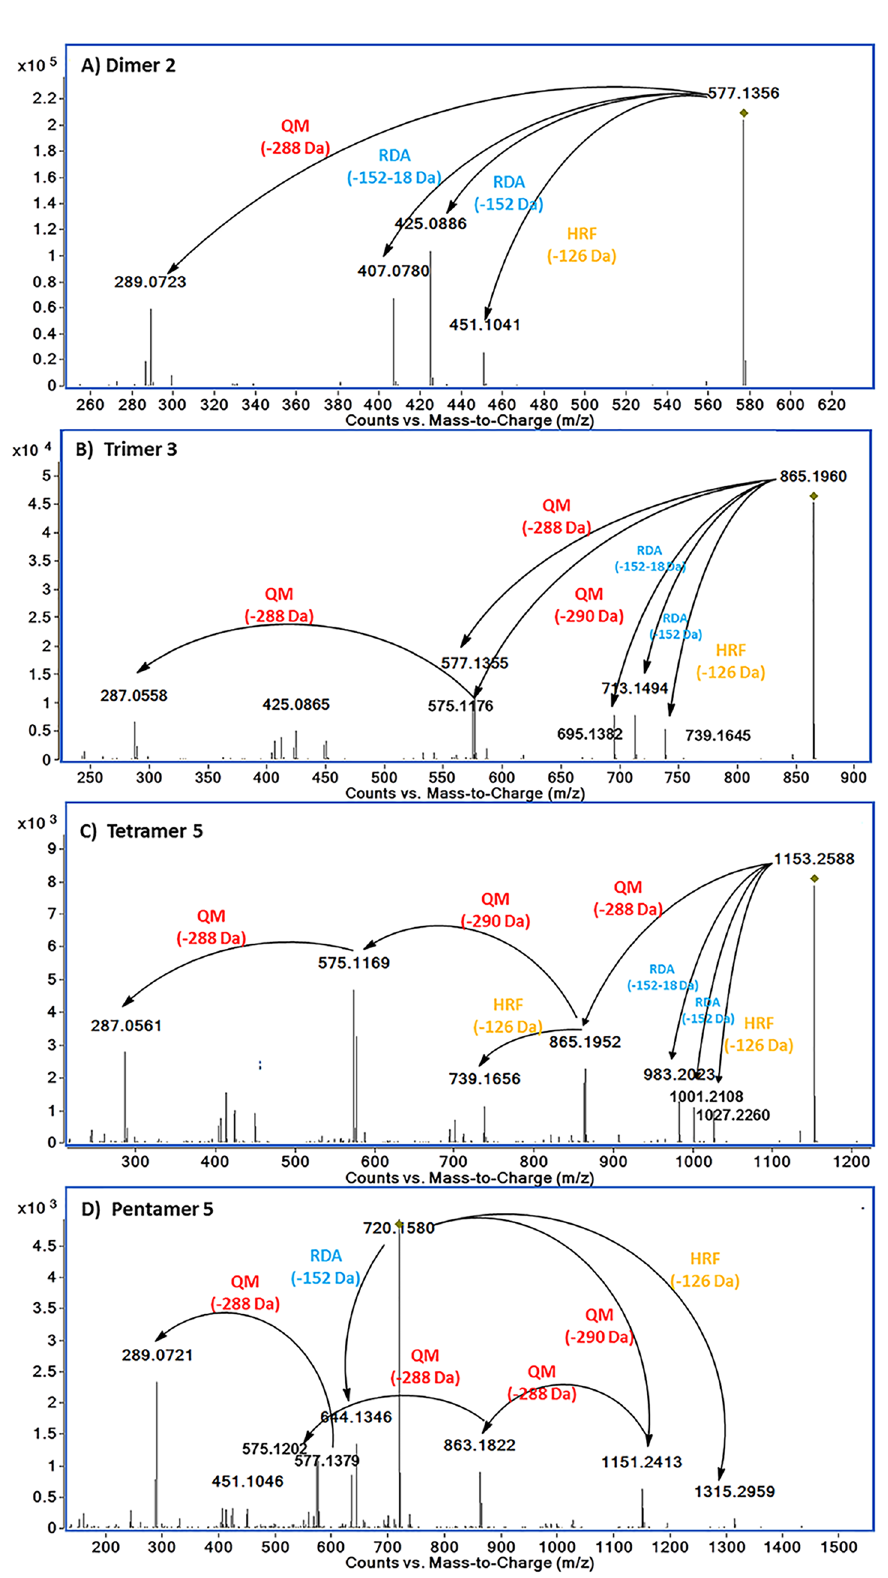
Fig 5. Examples of MS/MS fragments of purified dimeric, trimeric, tetrameric and pentameric PA.